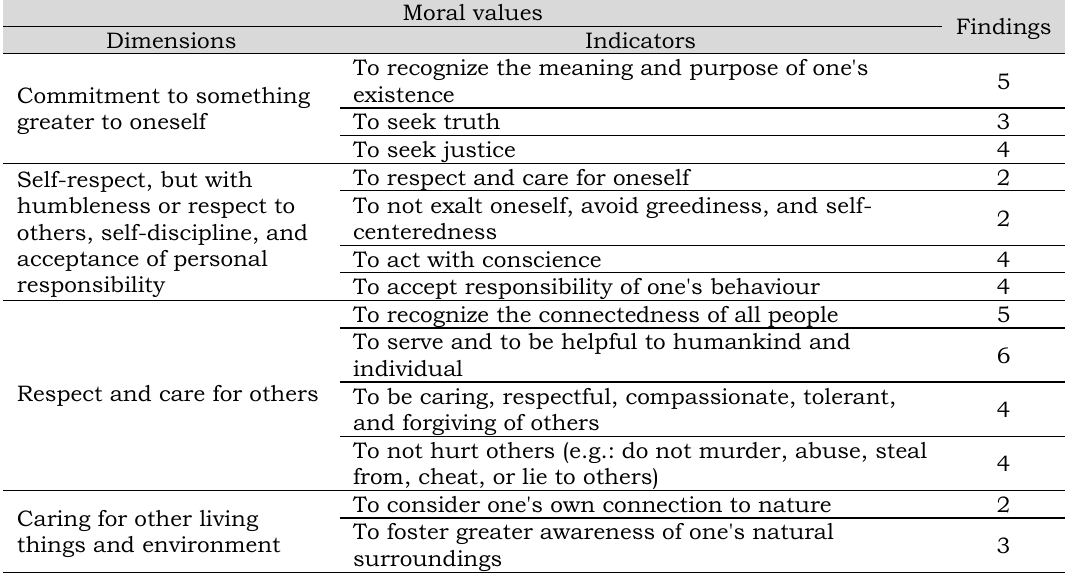
Table 2. Number of moral values portrayed in the novel Human